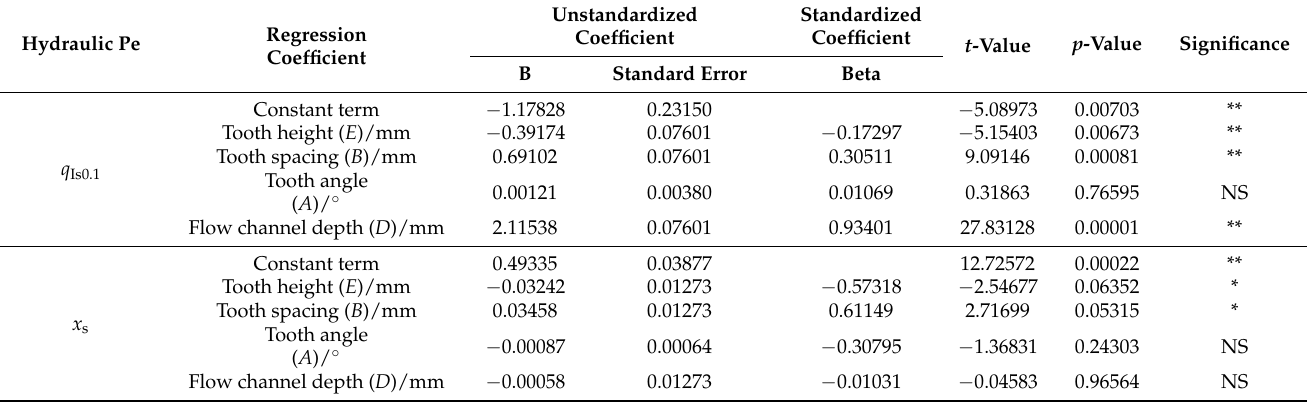
Table 5. Significance analysis of multiple linear regression coefficients for the hydraulic performance of flow rate at H = 0.1 MPa ( q Is0.1 ) and flow index ( x s ) with structural parameters.